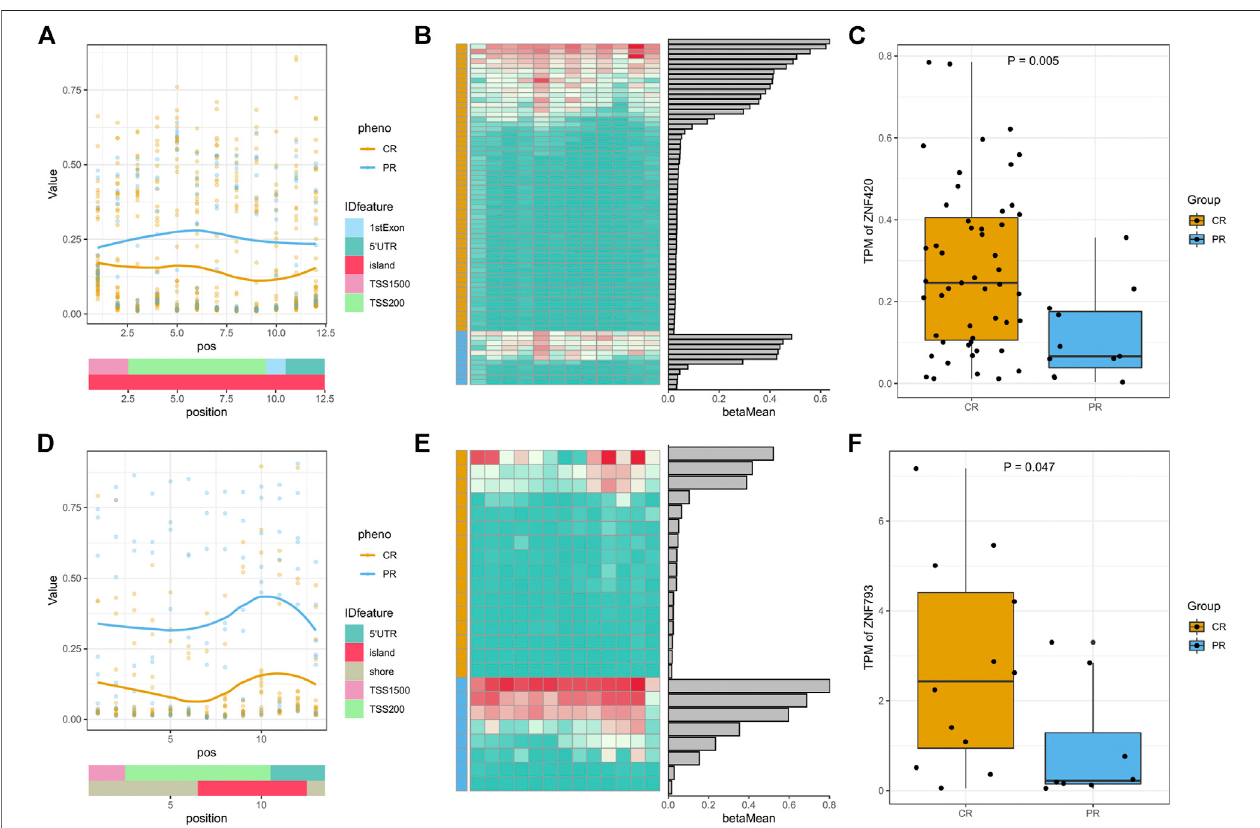
FIGURE3 | Methylation and expression ofZNF family genesin the DMRs ofHNSC and ESCA. (A) DMR plot ofthe methylation status ofCR/PR patients with gene featureand CpG islands (CGI) informationin head-neck squamous cellcarcinoma(HNSC) DMR-8. (B) Heatmap ofeach DMP betavalue and bar plots ofthemean beta values in HNSC DMR-8. (C) Expression (TPM) of relevant genes in speci fi c DMRs between the CR/PR groups in HNSC DMR-8. (D – F) DMR plot, heatmap, and gene expression in esophageal carcinoma (ESCA) DMR-8. p values were calculated using the Wilcoxon